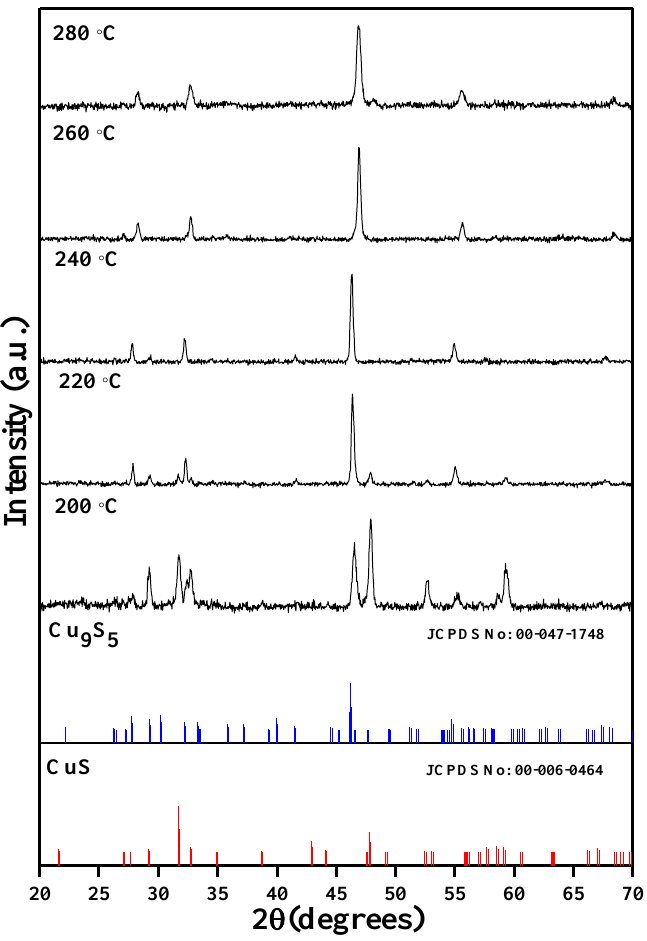
Figure 23. Powder X-ray diffraction patterns showing the evolution of pure phase Cu 9 S 5 from the thermolysis of [Cu(S 2 CNMePh) 2 ] in OLA.